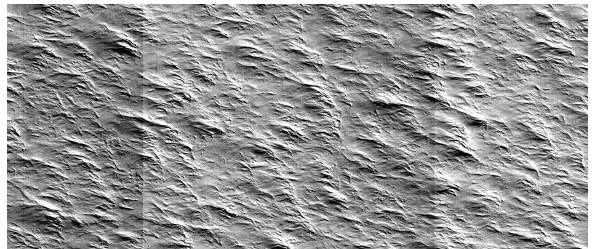
Figure 3. Raw PA Pleiades-HR image of Antarctic, vertical streaks are visible, © CNES Copyright 2012 A pre-launch full calibration has showed that the detector response has a bilinear response as a function of the input radiance L, unlike most satellites which have a linear response (Quickbird, WorldView-1 [5], Spot5, …).